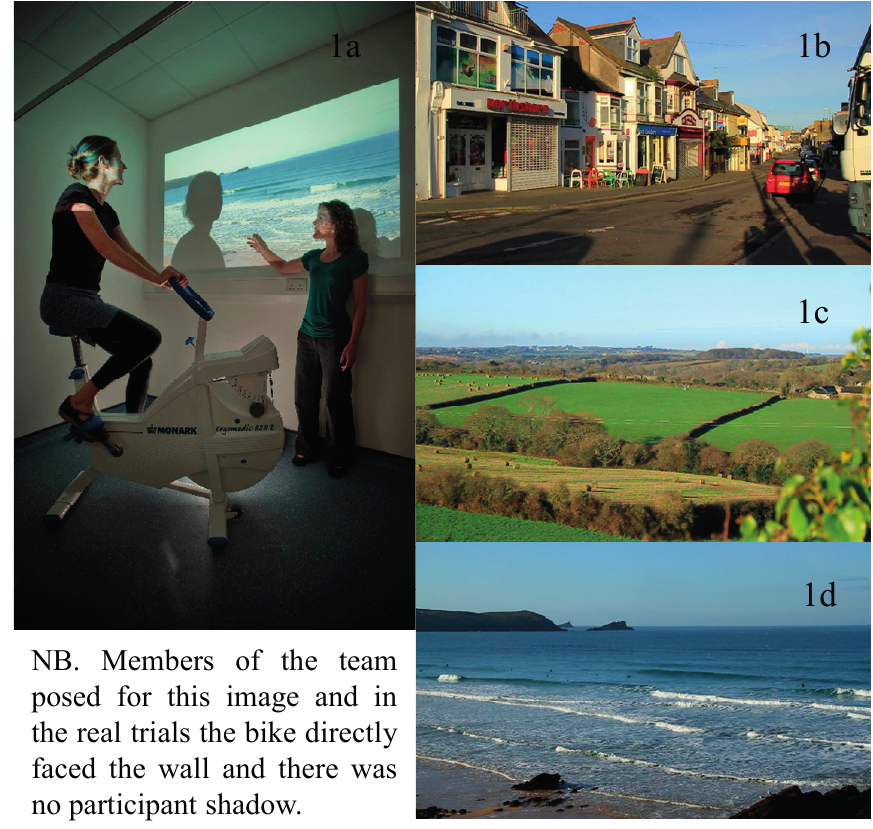
Figure 1. An image of the laboratory where the study took place ( 1a ) and screenshots from the three “outdoor” videos ( 1b – d